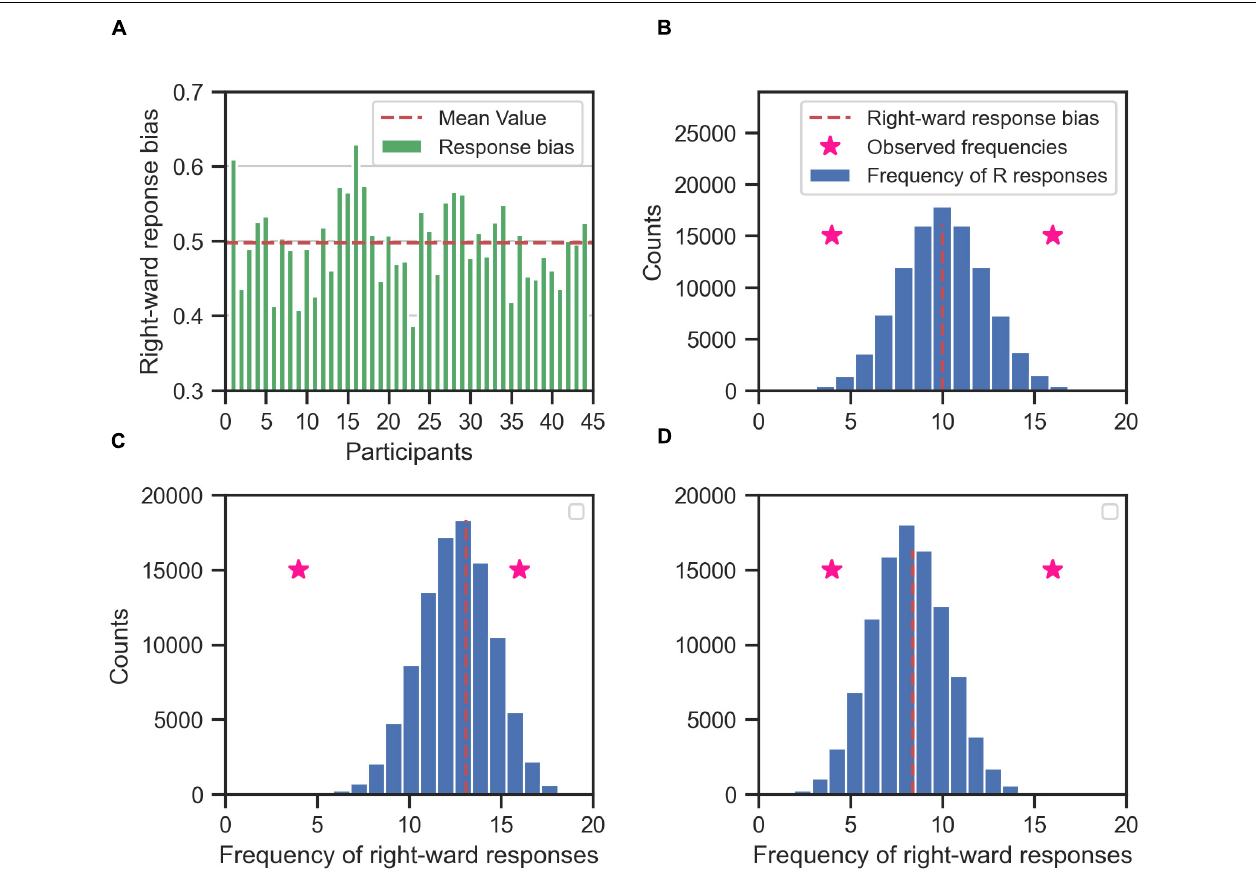
FIGURE 7 | Determining the consistent responses given the response bias (right) of the participants; the rightward responses bias for each participant (A) is used to create the null hypothesis distribution of frequency of rightward responses (blue histogram) for each participant (B–D, for three exemplary participants) . The null hypothesis distribution (the blue histogram) is binomial distribution centered on the rightward response bias of the participant (red dashed line). If the participant is in general unbiased toward right or left alternatives, then the null hypothesis distribution is centered around 10 (as in B ), i.e., half of the maximum number of responses for each stimulus type (20). If the participant is in general biased toward right (C) or left (D) the mean value of the null hypothesis is shifted toward 20 or 0, respectively. The null hypothesis distribution is used to determine the whether the observed frequency of rightward responses of the participant to a specific stimulus type (two exemplary pink stars for two different stimulus types) is consistent. If an observed frequency is extreme enough w.r.t. to mean of the null hypothesis distribution, then the response of the participant to that stimulus type is consistent. For example, the observed rightward frequency of 16 is consistent in (B,D) , but not in (C) . Likewise, the observed rightward frequency of 4 is consistent in (B,C) , but not in (D)